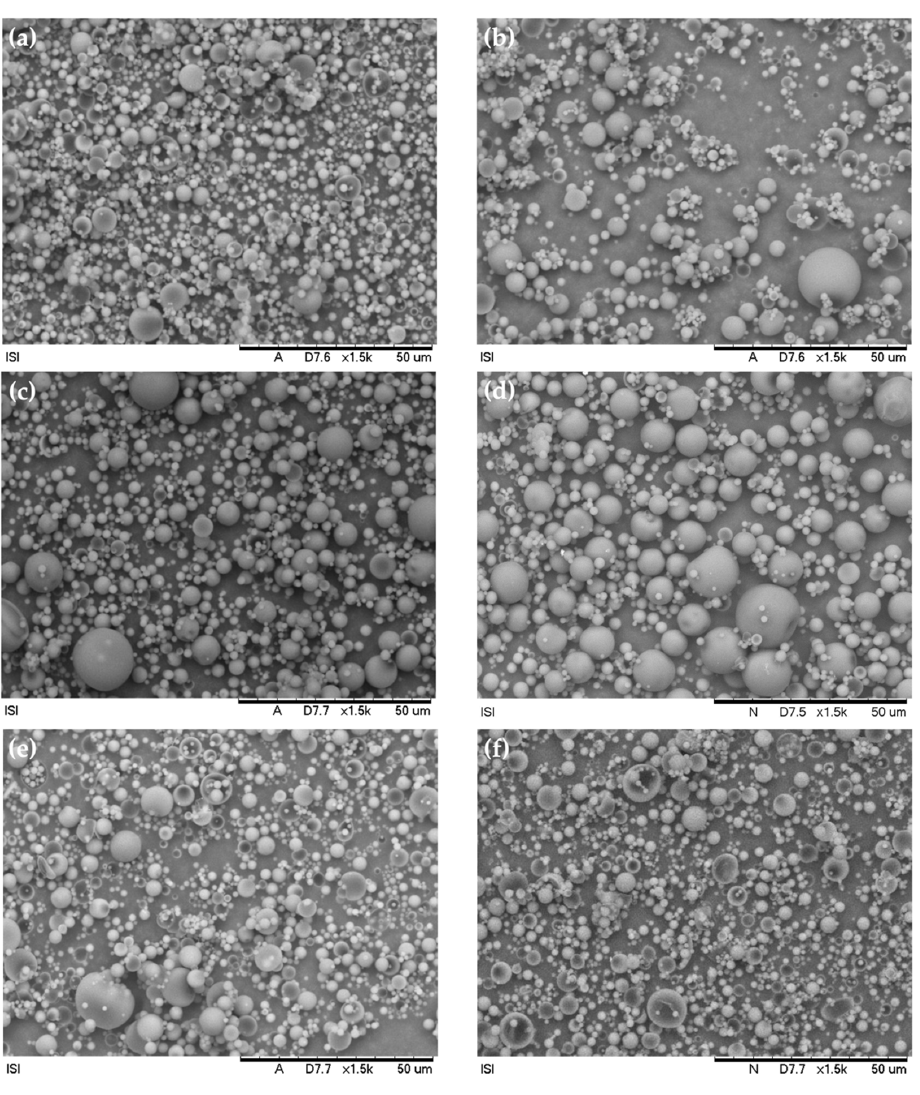
Figure 2. SEM images of CMC.BTA microspheres obtained by spray drying with different experi ‐ mental conditions (inlet temperature and spray flow rate): ( a ) 170 °C and 440 L/h; ( b ) 170 °C and 600 tal conditions (inlet temperature and spray flow rate): ( a ) 170 ◦ C and 440 L/h; ( b ) 170 ◦ C and 600 L/h; L/h; ( c ) 180 °C and 440 L/h; ( d ) 180 °C and 600 L/h; ( e ) 190 °C and 440 L/h; and ( f ) 190 °C and 600 ( c ) 180 ◦ C and 440 L/h; ( d ) 180 ◦ C and 600 L/h; ( e ) 190 ◦ C and 440 L/h; and ( f ) 190 ◦ C and 600 L/h. L/h.